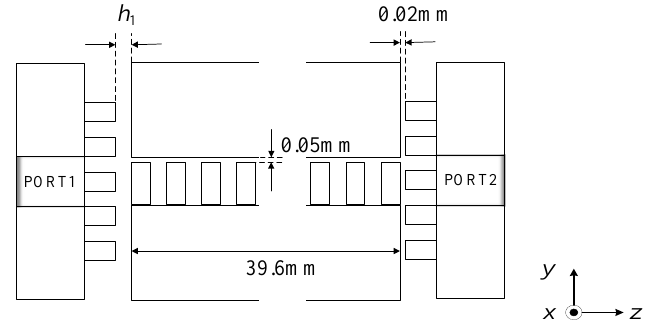
Figure 9. Side-view of the transition in the yz plane. h 1 is the distance between unit#1 and #2 in the z _ direction on PORT1 side.